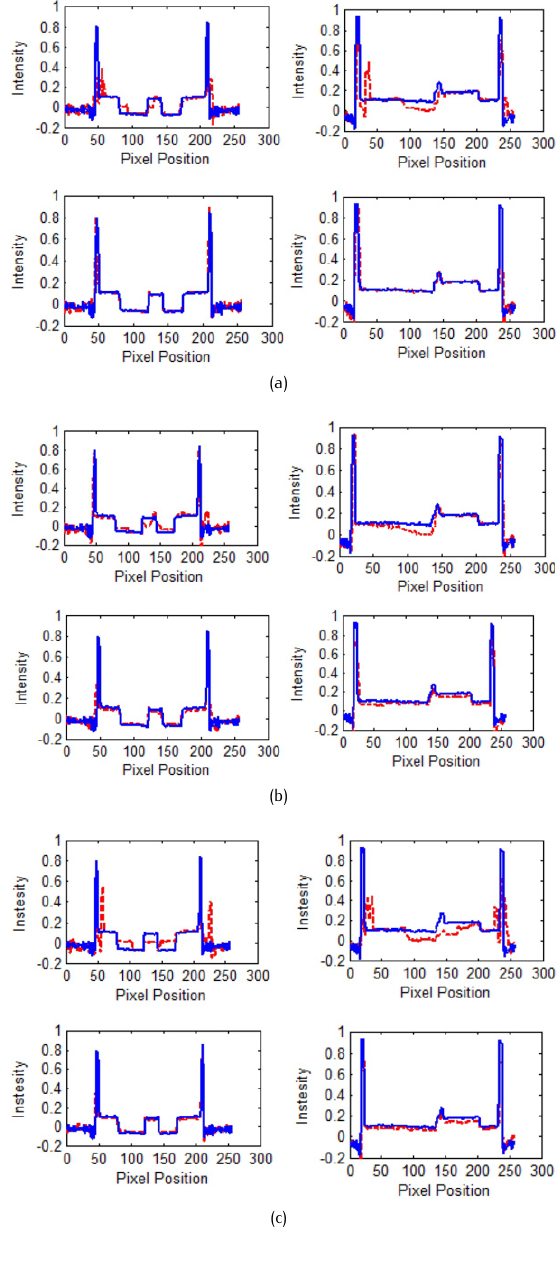
Figure 21. Comparison of one pixel wide intensity profiles taken from the axial slices (at z = − 2 . 5 cm) of different cases. Motion free case (solid line). Left col. – intensity profiles at Y = 129 th position, Right col. – intensity profiles at X = 131 st position. (a) Translation Motion case. (b) Rotational Motion case. (c) Combined motion case. Dotted lines in (a), (b) and (c) – (1 st row – motion corrupted case, 2 nd row – motion compensated